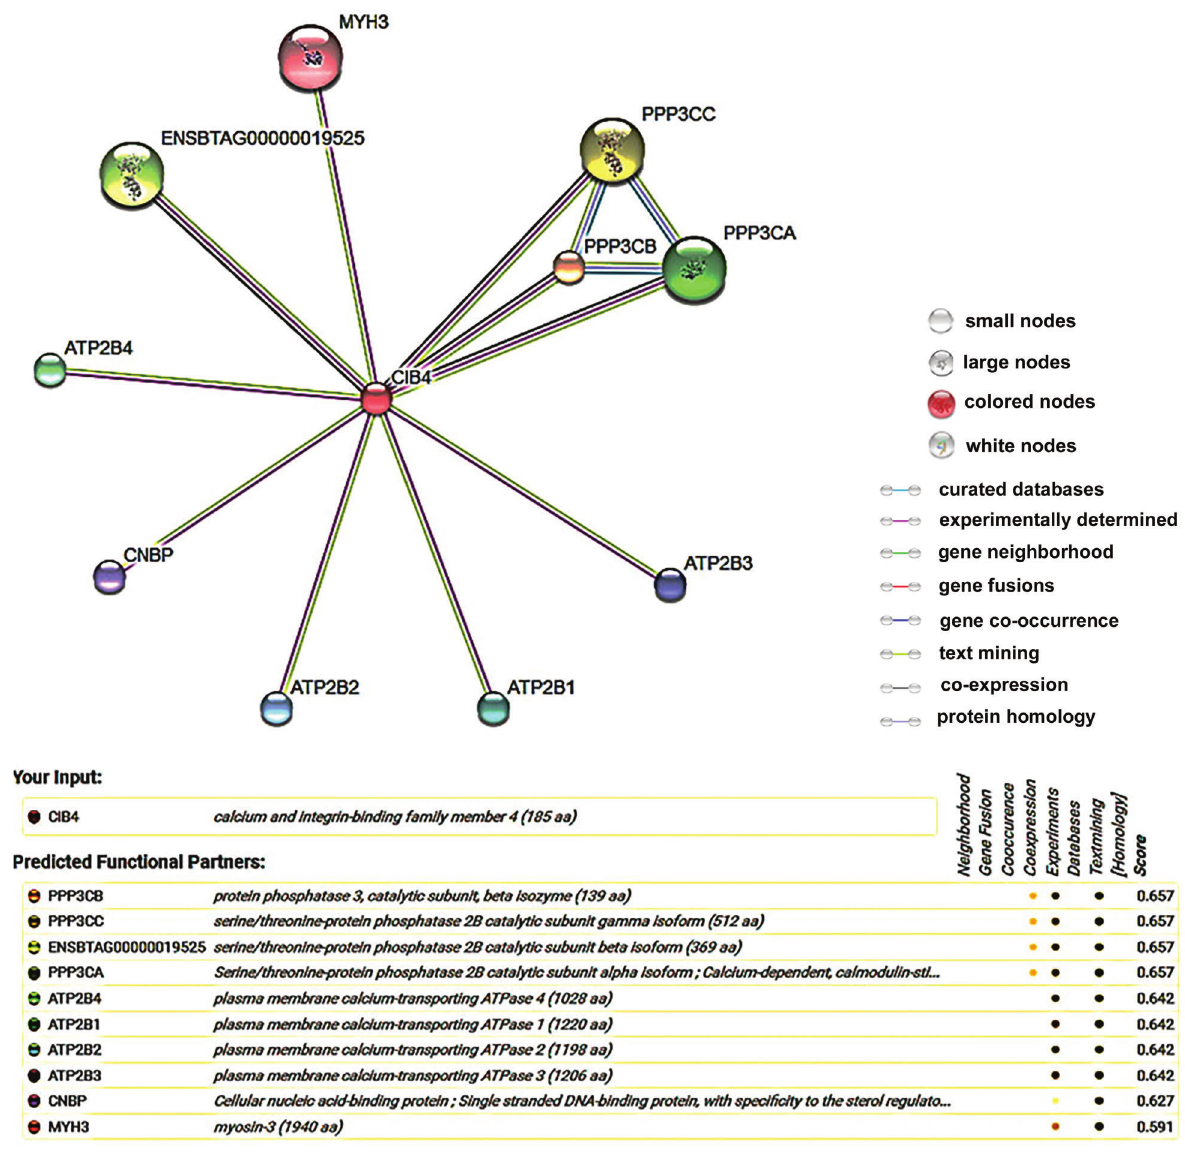
Figure 7. Kermani sheep CIB4 interaction with other predicted proteins and description of predicted functional partners using the STRING program. Different line colors represent the types of evidence for the association. Line thickness relates to combined score. Small nodes are protein of unknown 3D structure. Large nodes are some 3D structures known or predicted. Colored nodes are query proteins and fi rst shell of interactors. White nodes are second shell of interactors. Edges are protein-protein associations. Associations are meant to be speci fi c and meaningful, i.e., proteins jointly contribute to a shared function. This does not necessarily mean they are physically binding to each other. Known interactions are from curated databases or are experimentally determined. Predicted interactions are gene neighborhood, gene fusions and gene co-occurrence. Others are text mining, co-expression, and protein